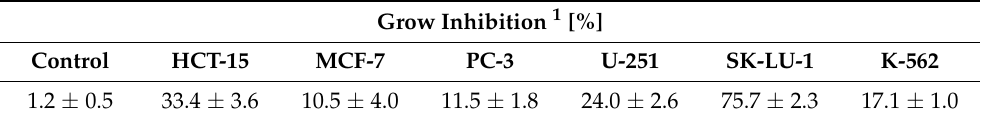
Mean values ± SD of replicate samples analyzed in duplicate.